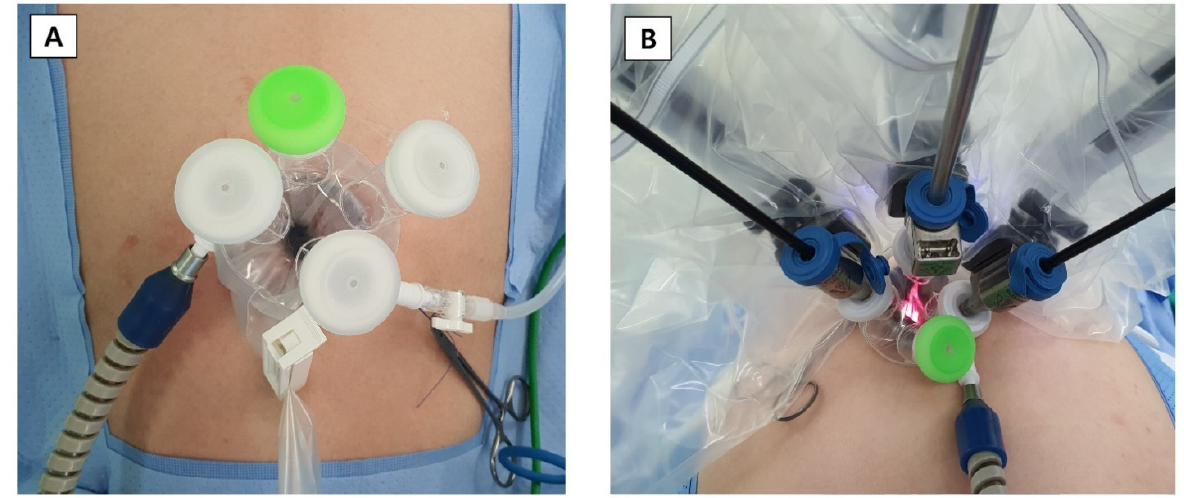
Figure 1. Single-site placement for robotic surgery. ( A ) Before docking. ( B ) After